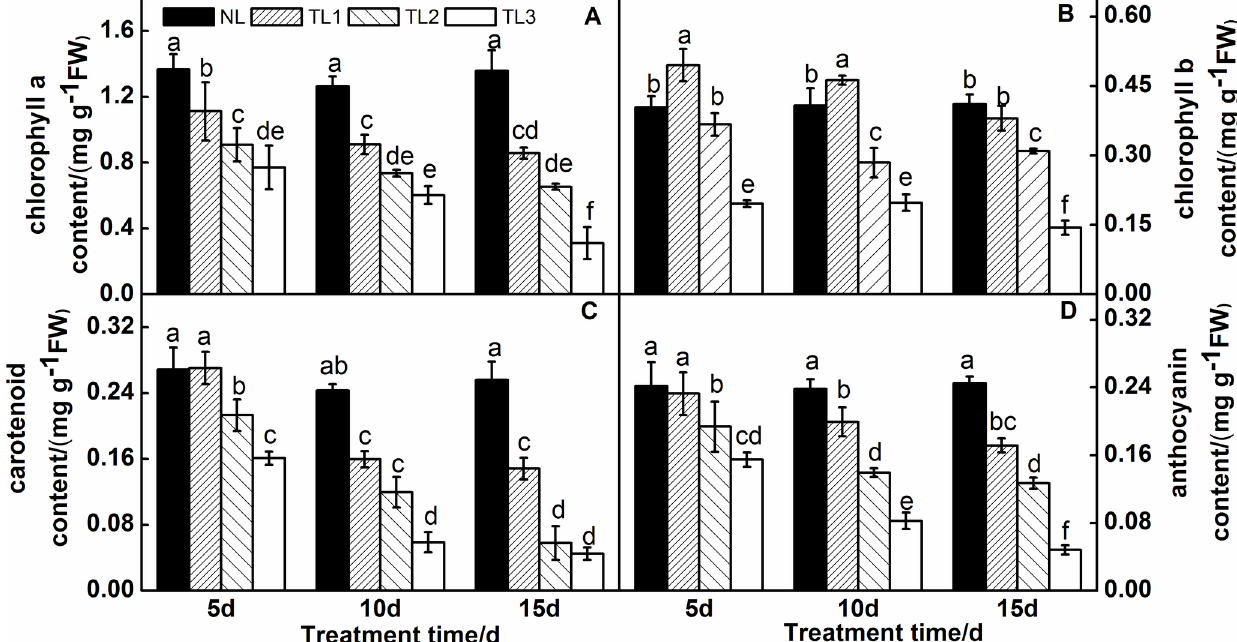
Fig 2. Effects of low light treatment on chlorophyll a (A), chlorophyll b (B), carotenoid (C) and anthocyanin (D) content in leaves of purplepak- choi seedlings.The data are the mean of three replicates, and SDs are shown as vertical bars . The means marked with different letters indicate significantdifferences betweentreatments at p < 0.05,as determined with Duncan’smultiple range test. Different lower-caseletters at each time point indicatesignificantdifferences betweentreatments. FW is the abbreviation of fresh weight.